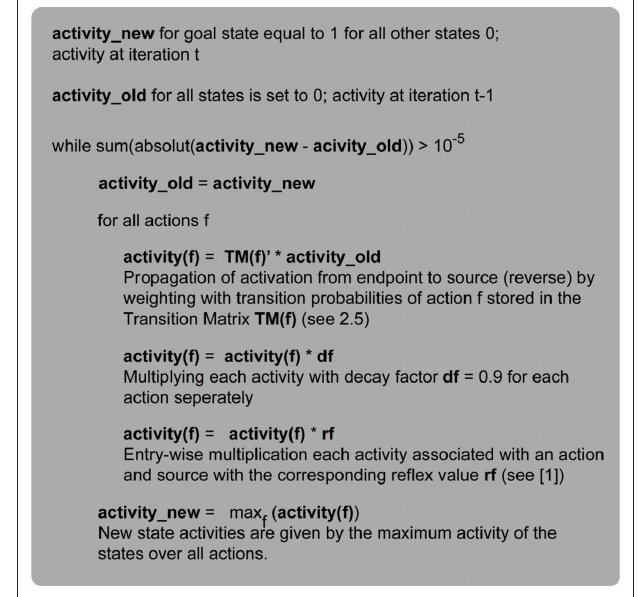
Figure  | Description of the reverse flooding